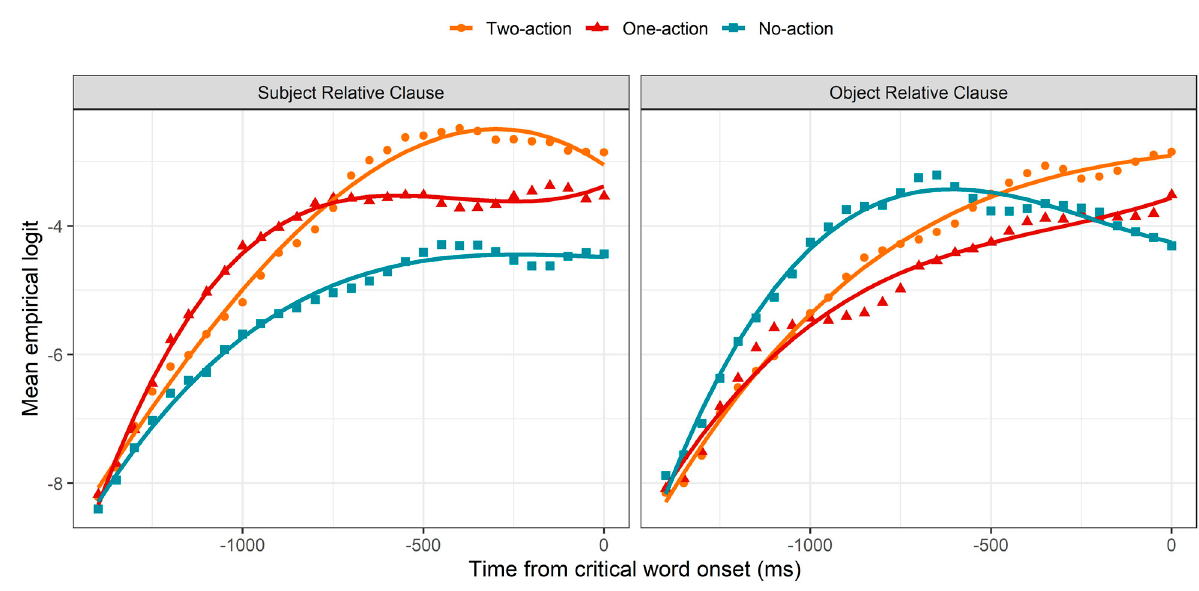
Figure 3. GCA model fit (lines) of empirical logit (points) as a function of image in the visual context and sentence type for the anticipation region.